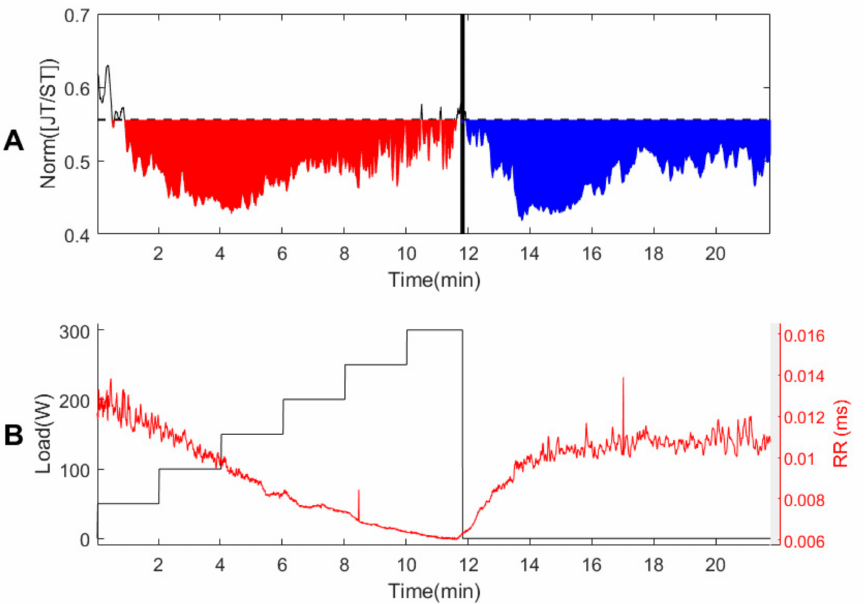
Figure 8. The dynamics of the JT/ST relationship during the load and recovery processes for person #7. The x -axis in parts ( A , B ) represents the time (measured in minutes) from the beginning of the cycle ergometry exercise. The left y-axis in part ( B ) represents the power of the load in Watts. The right y-axis in part ( B ) represents the variation of the RR interval in ms. The algebraic JT/ST relationship is represented by the thin dashed black line in part A. The thick black solid vertical line in part A marks the end of the